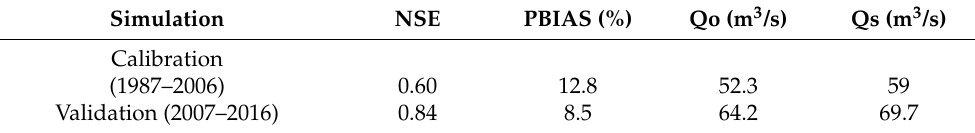
Table 6. Values of simulated (Qs) and observed (Qo) average flow metrics.